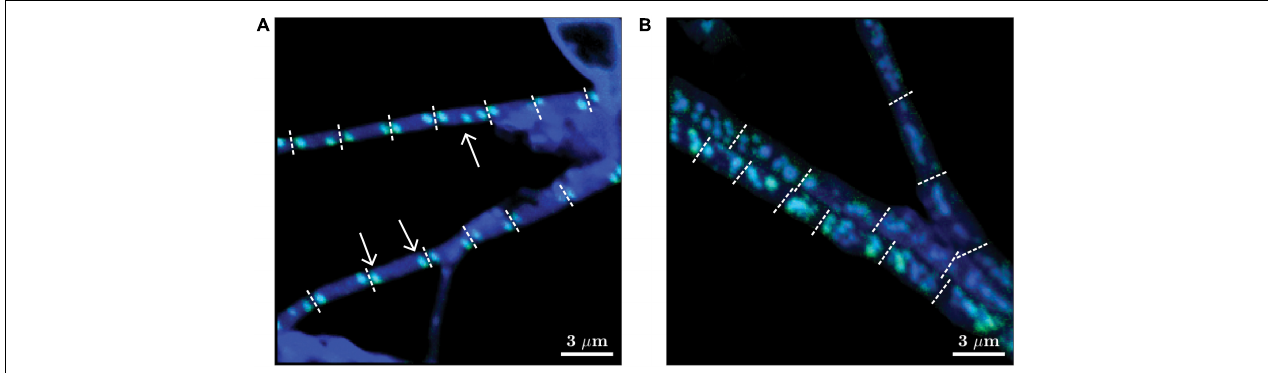
FIGURE 2 | Representative images of two morphotypes of cable bacteria observed in this study. Images are shown as overlays of the 18 O atom fraction (in green) and 31 P ion counts (in blue). (A) “ Thin” filaments (diameter 0.5-1 µ m) mostly contained two poly-P granules at the poles of each cell, but cells containing three poly-P granules were occasionally also observed (see white arrows). (B) “Thicker” filaments (diameter > 1 µ m) contained multiple poly-P granules per cell. Filaments shown in panels (A,B) were retrieved from the transition zone after 24 h of labeling and from the suboxic zone after 6 h of labeling, respectively. Dotted white lines depict cell junctions. Scaling for the green and blue colors was optimized independently for each image to enhance the visibility of the poly-P granules. Scale bar is 3 µ m. The original images of the 18 O atom fraction and 31 P ion counts are shown in Supplementary Figure 3